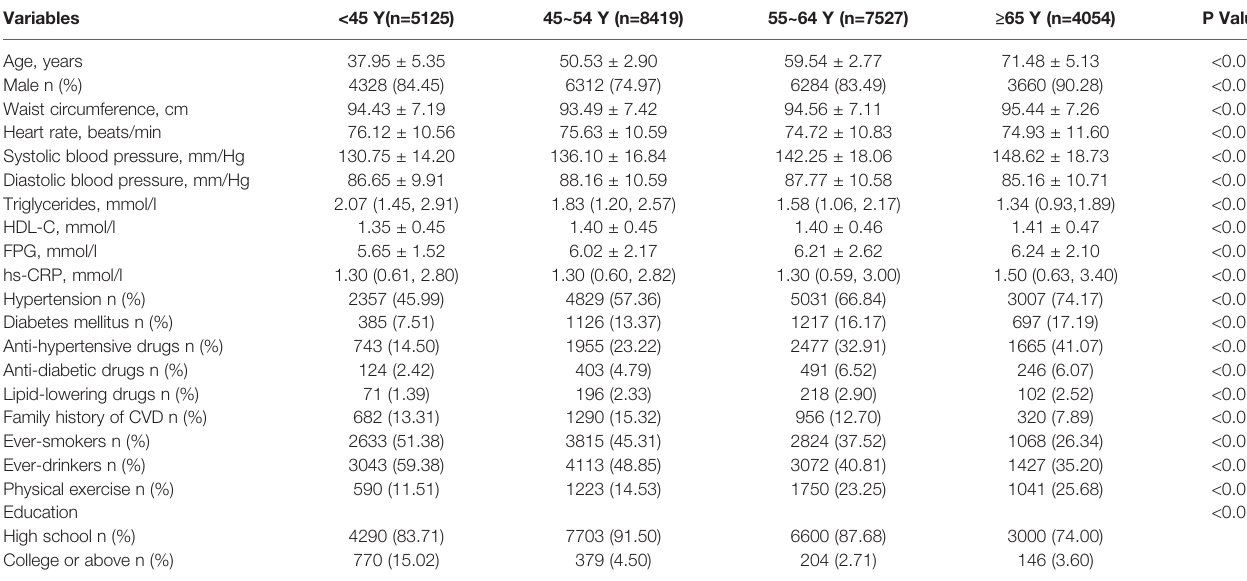
TABLE 2 | Basic characteristics for new-onset MetS participants across age